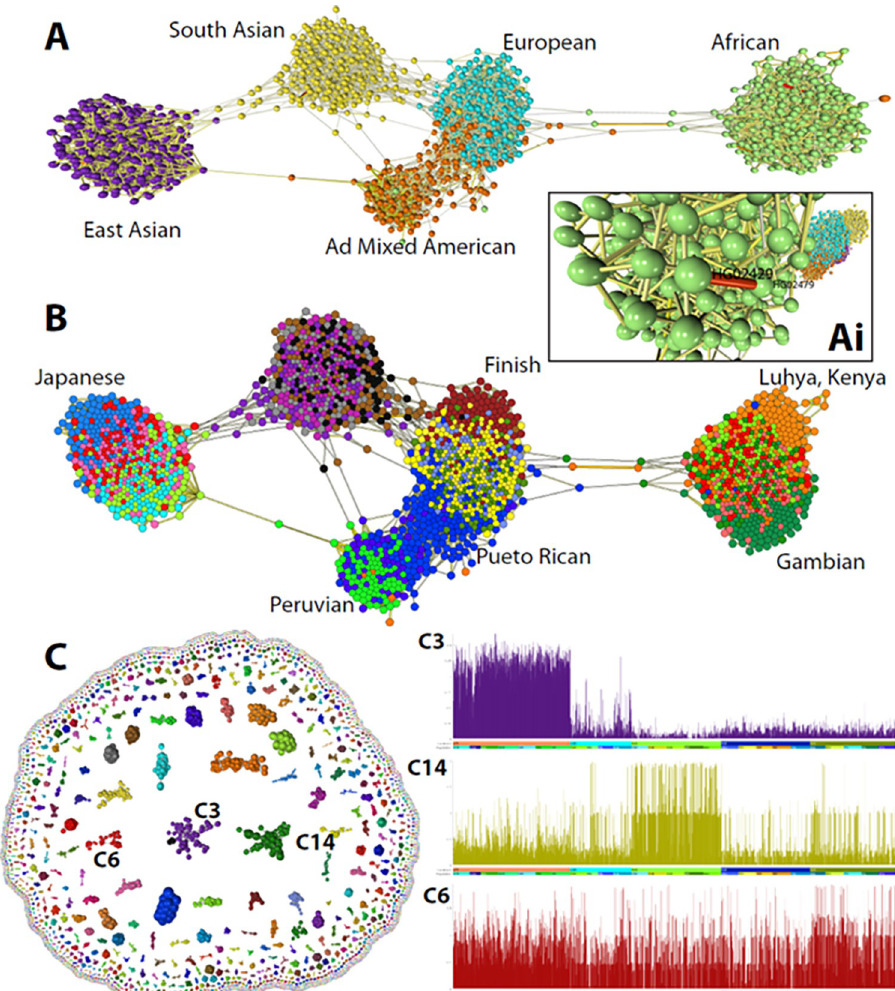
Fig 6. Analysis of single nucleotide genome variant data. (A) The graph shown was constructed from data from the 1000 genomes project based on the correlation ( r threshold = 0.238) between the allele dosages at 23,675 SNVs from chromosome 22. Nodes represent the 2,504 individuals included in the study and edges the three most significant correlations with their neighbours (k-NN was applied where k = 3). In most cases, individuals’ group with others from the same continent although there are instances where this does not appear to be the case. Visualisation of edge weights (Ai) also highlights cases where individuals would appear to be closely related. (B) Colouring of nodes by the attribute ‘population’ provides a higher resolution to the graph and populations showing a high degree homogeneity have been labelled. (C) Transposing the data upon import demonstrates SNVs whose pattern across the genome covaries. Clustering of these data shows many to represent haplotype blocks and inspection of their profile across genomes, demonstrates some SNV clusters to be associated with a given ethnic grouping, e.g. cluster 3 (Africans) and cluster 14 (East Asia), whilst others little obvious association with ethnicity, e.g. cluster 6. Plots show the average score of SNV’s within a cluster (y-axis, 0,1,2), across the 2,504 individuals ordered by continent and then population